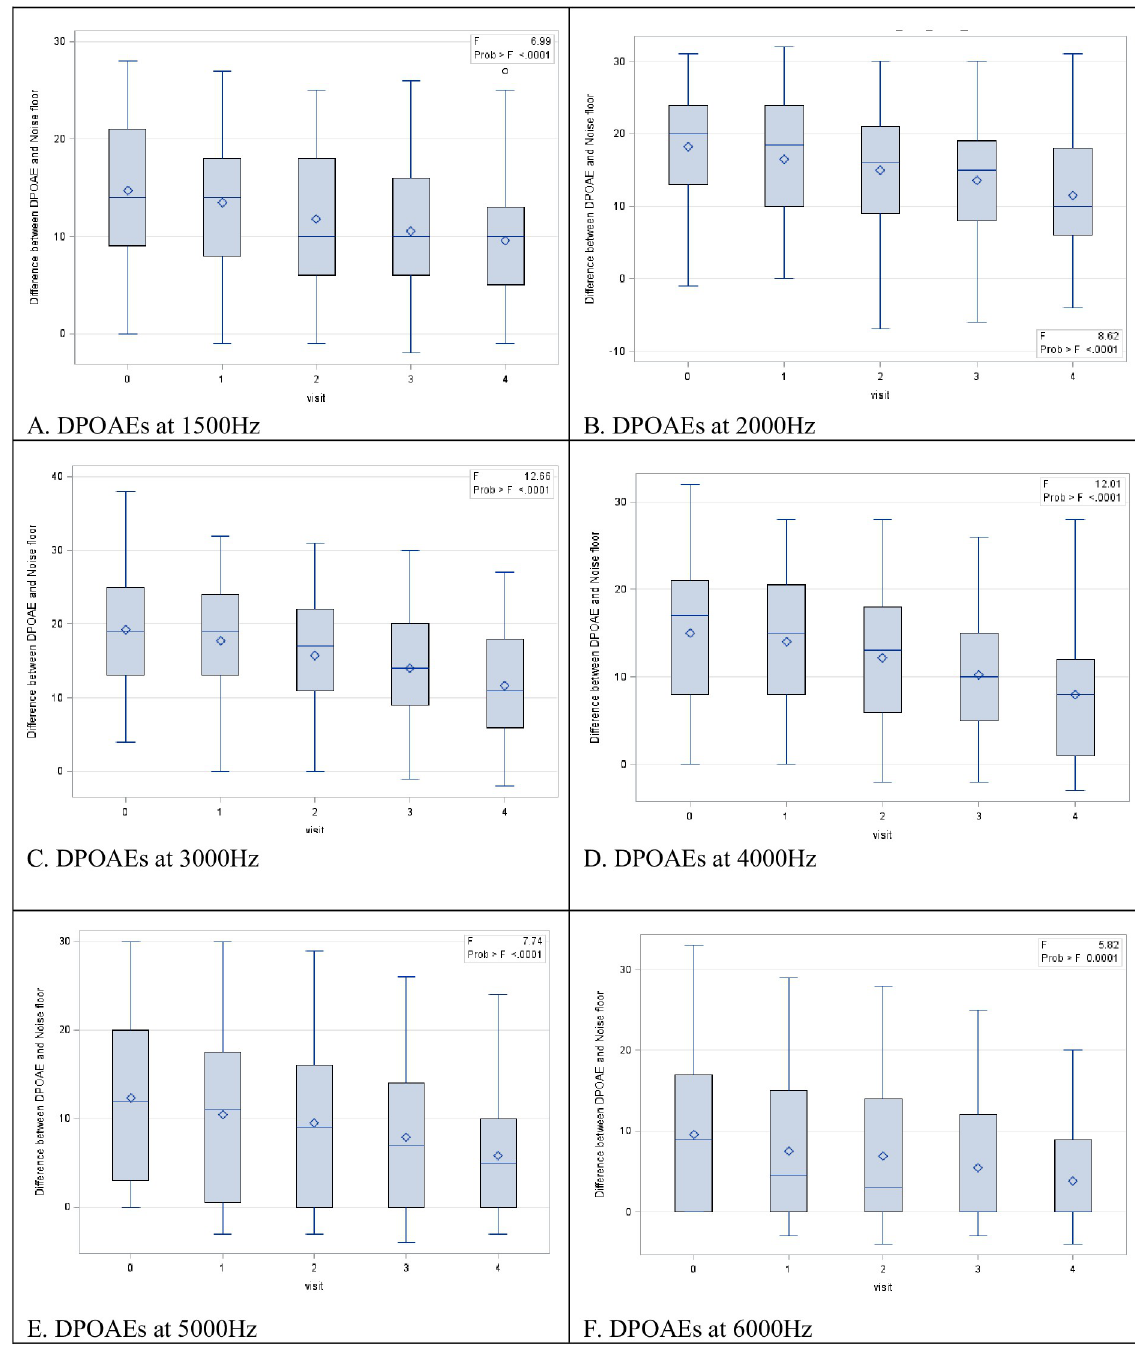
Fig 2. Box plots reflecting the change in the difference between the DPOAE and the noise floor at all frequencies in the right ear. ANOVA test revealed a significant decrease (p < 0.05) in the difference between the DPOAE and noise floor at each audiological evaluation. significant at one- (p = 0.017), three- (p = 0.009) and six-month (p = 0.015) post-cisplatin treat- ment. At the end of the 6-month follow-up, 15/47 (32%) of patients in the high-dose group were in the Grade 2/3 category compared to only 5/33 (15%) of the patients in the low-dose group.